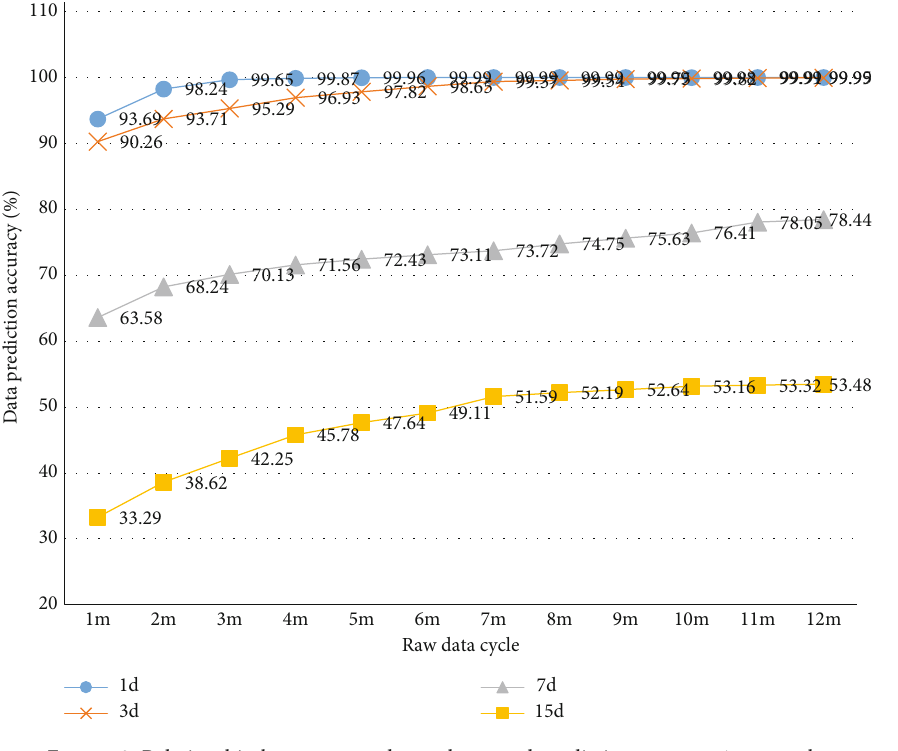
Figure 3: Relationship between raw data volume and prediction accuracy /m=month. Table 2: Relationship between the number of relevant data columns and the prediction